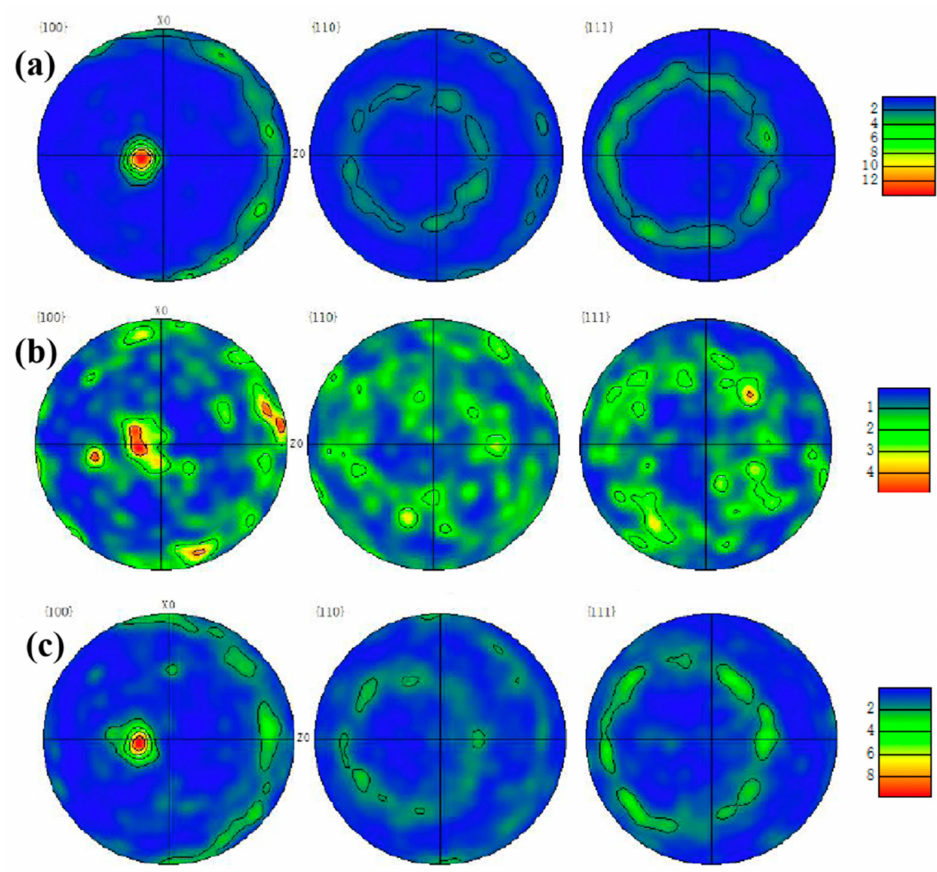
Figure 5. Pole figures of {100}, {110}, {111} planes in the Cr-coating samples. ( a ) 1#, ( b ) 2# and ( c ) 3#. The grain orientation and morphology of the Cr-coatings are closely related to the oxidation resistance. In the nuclear environment, Zry-4 alloy will absorb oxygen and hydrogen, forming zirconium oxides and hydrides, which shortens the service life of the alloy. The formation of oxides and hydrides is related to the grain morphology of the coating and the habit planes of precipitation. Some studies showed that [12,13] hydrogen atom diffused rapidly into the matrix through the grain boundary, nucleated at the grain boundary of zirconium alloy to form δ -zirconium hydride, and grew rapidly along the grain boundary until it met other grain boundaries.